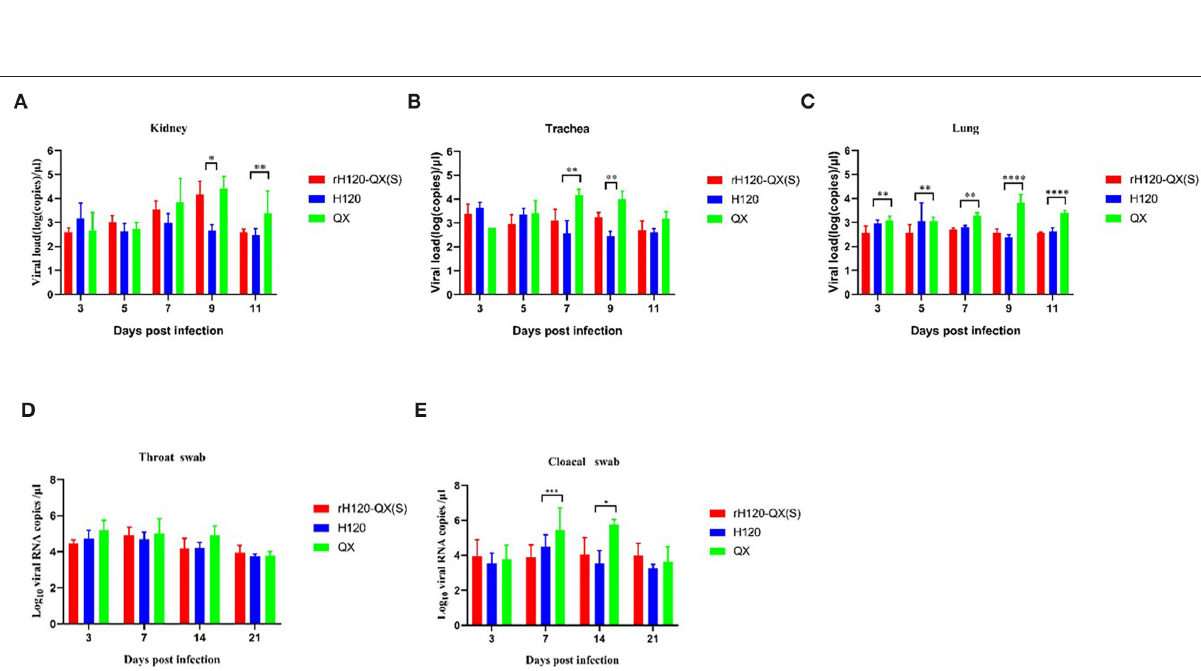
Frontiers in Microbiology |